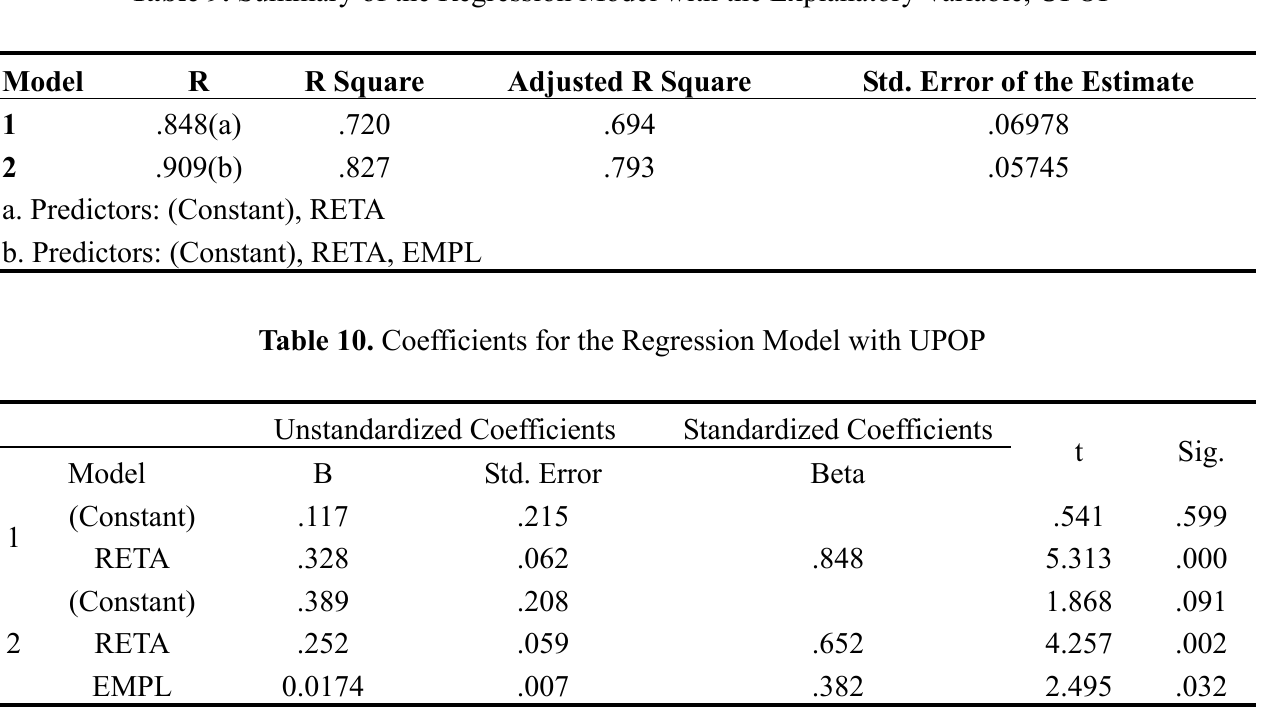
Table 9. Summary of the Regression Model with the Explanatory Variable, UPOP